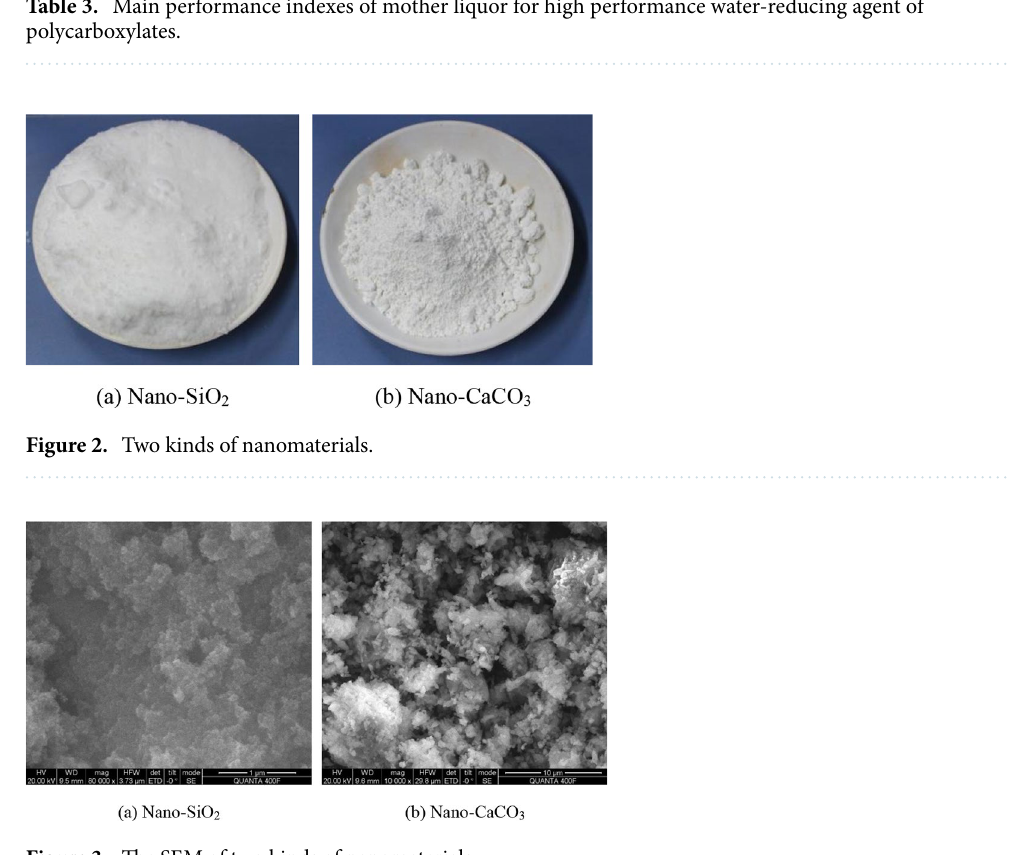
Figure 3. The SEM of two kinds of nanomaterials.